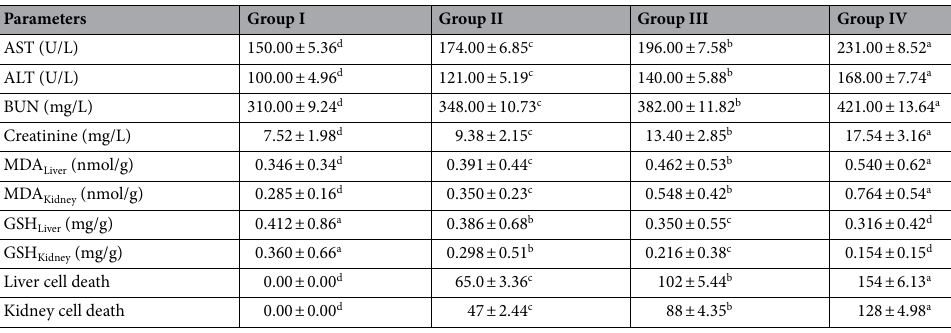
Table 2. Effects of Paraquat on selected biochemical parameters and viability of liver and kidney cells. Group I: Control, Group II: 50 mg/kg b.w Paraquat, Group III: 100 mg/kg b.w Paraquat, Group IV: 200 mg/kg b.w Paraquat. AST aspartate aminotransferase, ALT alanine aminotransferase, BUN blood urea nitrogen, MDA malondialdehyde, GSH glutathione. In cell viability test, 100 cells were counted for each mouse in each group, a total of 600 cells. Values are shown as mean ± SD (n = 6). Means shown with different letters on the same line are significantly different (p < 0.05).